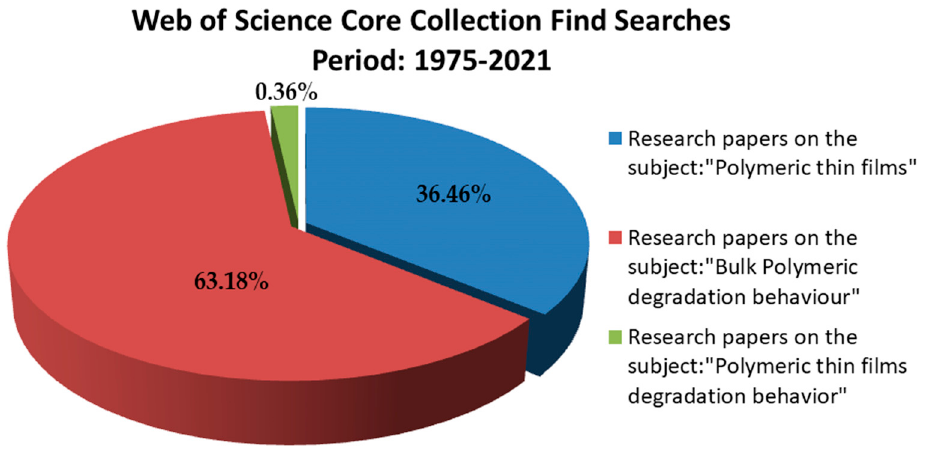
Figure 2. Current state of relevant publications available in the reviewed research field for studies related to the degradation of polymers in form of coatings.